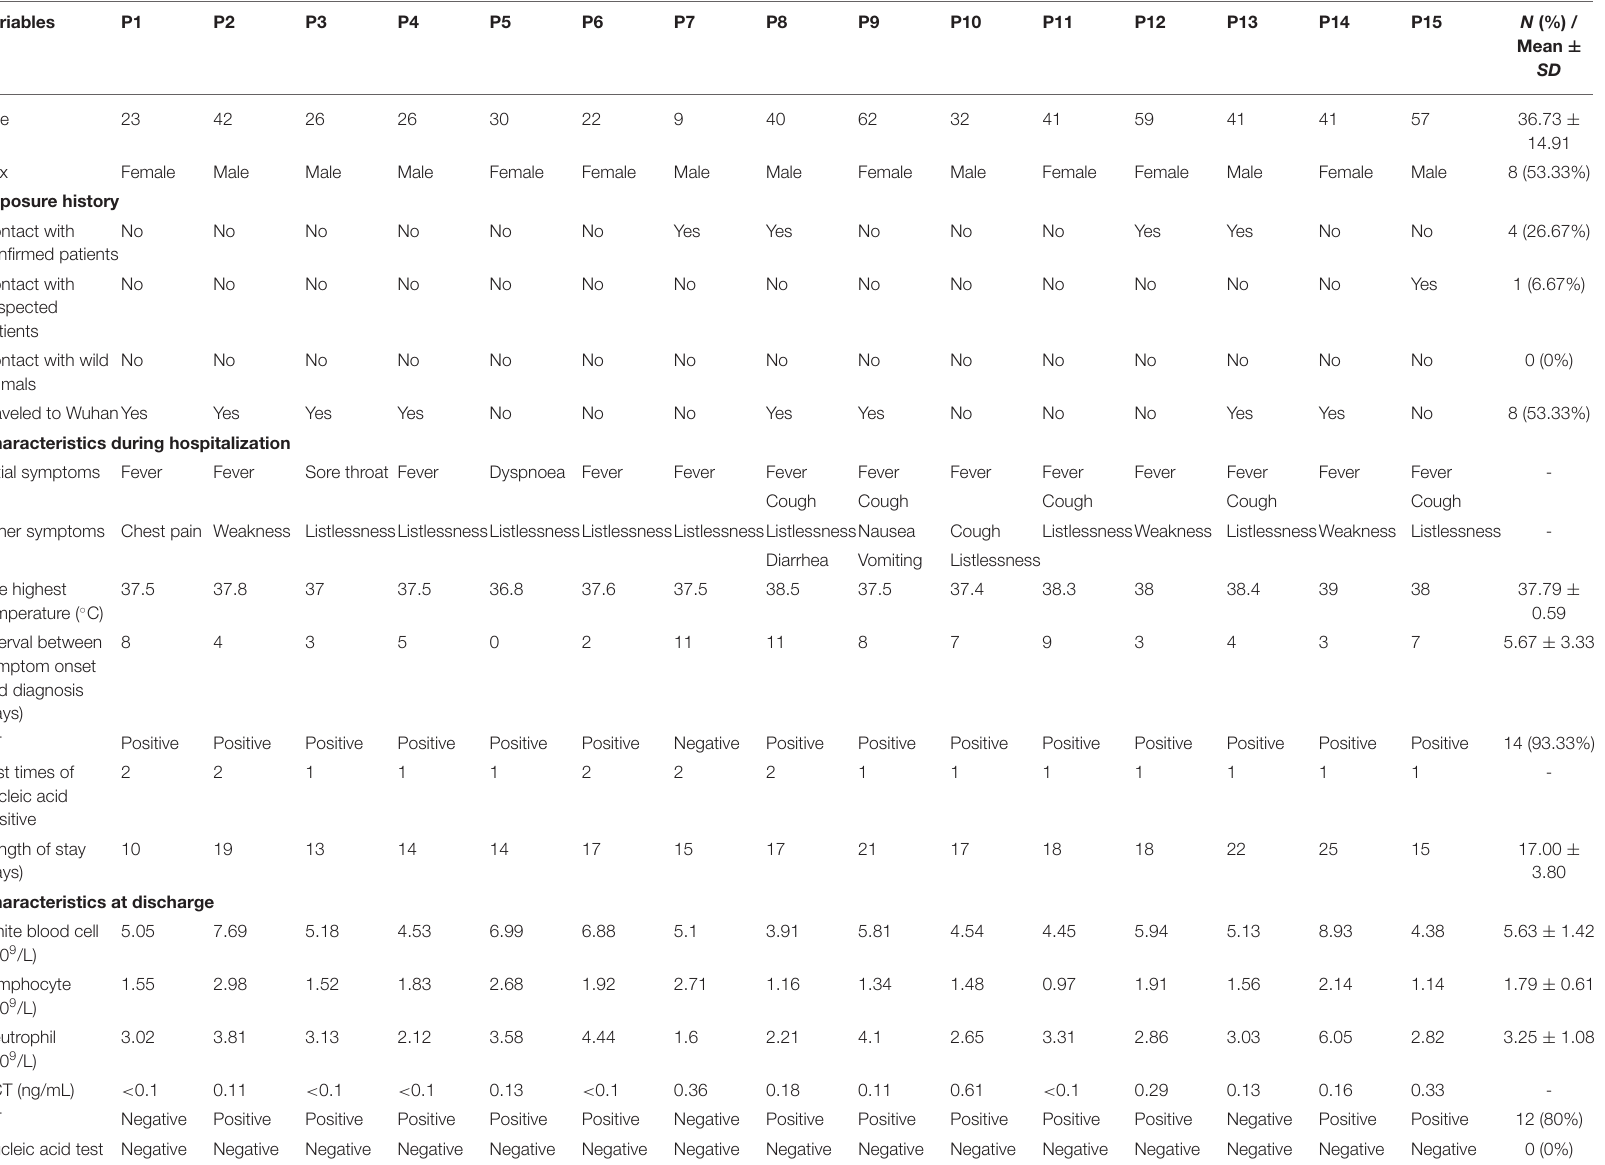
TABLE 1 | The exposure history and characteristics of COVID-19 patients during hospitalization and at discharge. Variables